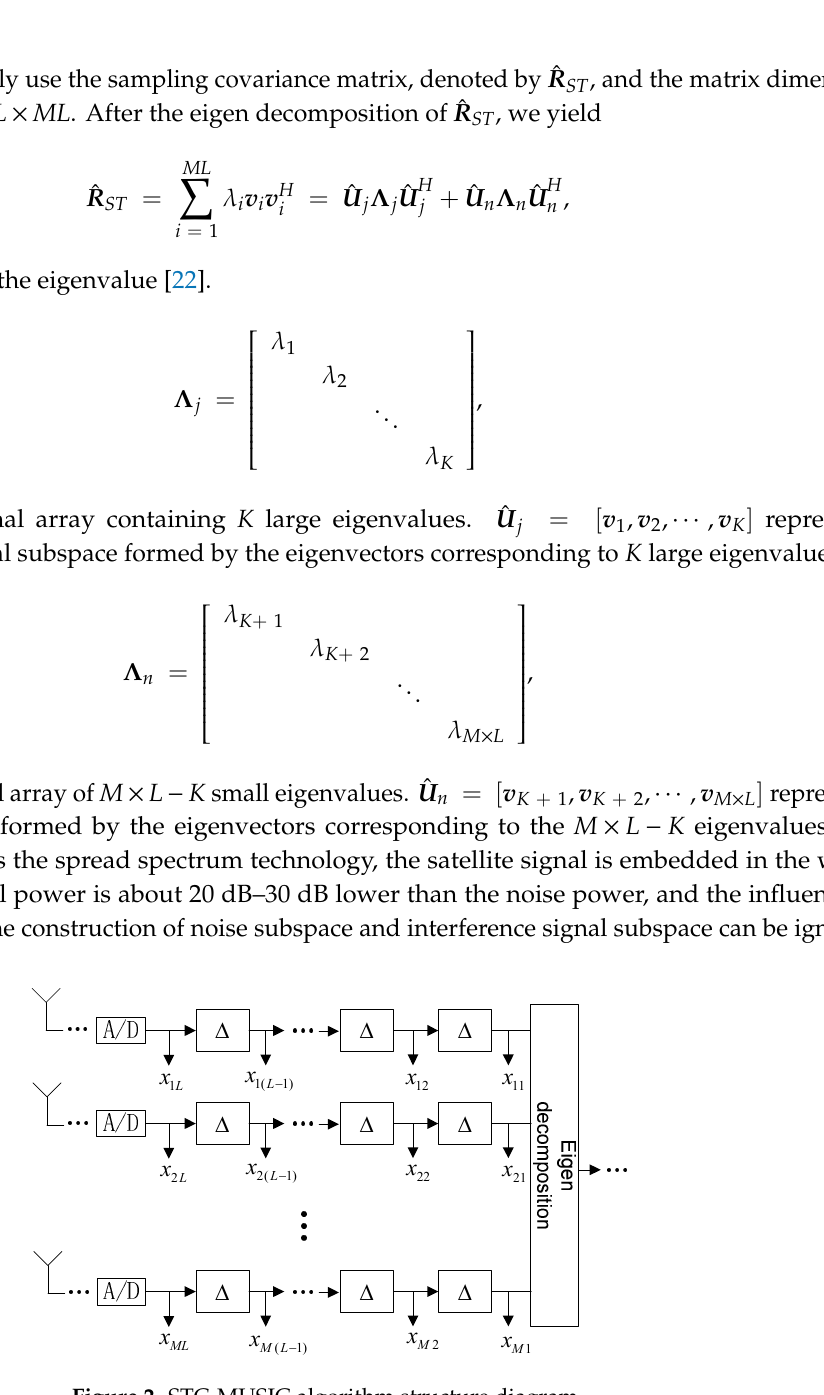
Figure 2. STC-MUSIC algorithm structure diagram.